Question: Write a descriptive caption for this figure.
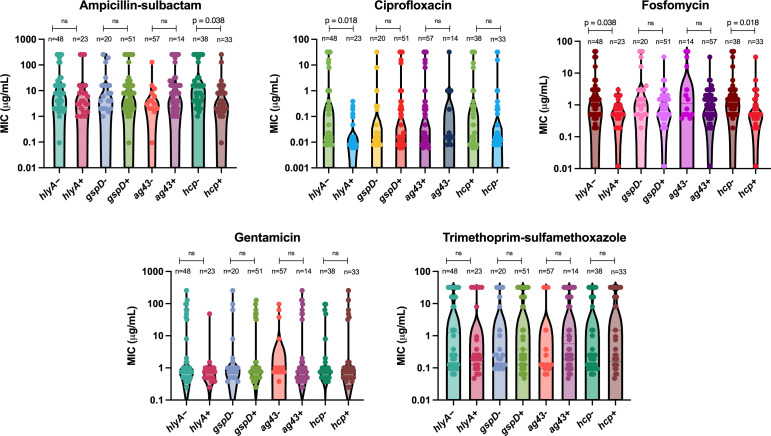
Answer: Secretion-system markers associate with MIC distributions for tested antibiotics. Violin plots show MIC (µg/mL) distributions for clinical UPEC isolates grouped by carriage of each specific secretion-system marker gene: hlyA , gspD , ag43 , and hcp . Each dot represents a single isolate; central lines indicate the median and interquartile range, and n stands for the number of isolates. Pairwise comparisons were performed using Mann-Whitney U tests with Benjamini-Hochberg FDR correction. Adjusted P values are shown on the graph for statistically significant comparisons; ns indicates non-significant comparisons.